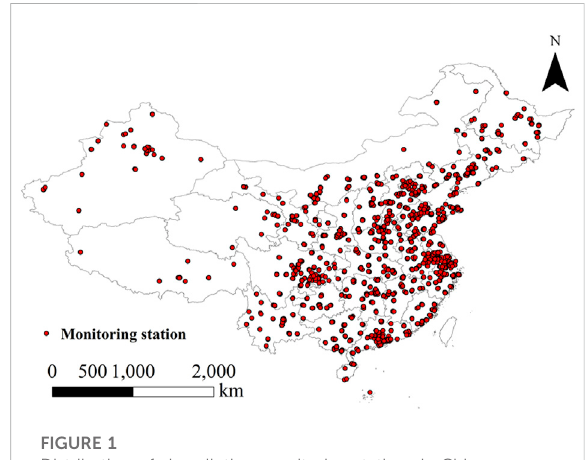
FIGURE 1 Distribution of air pollution monitoring stations in